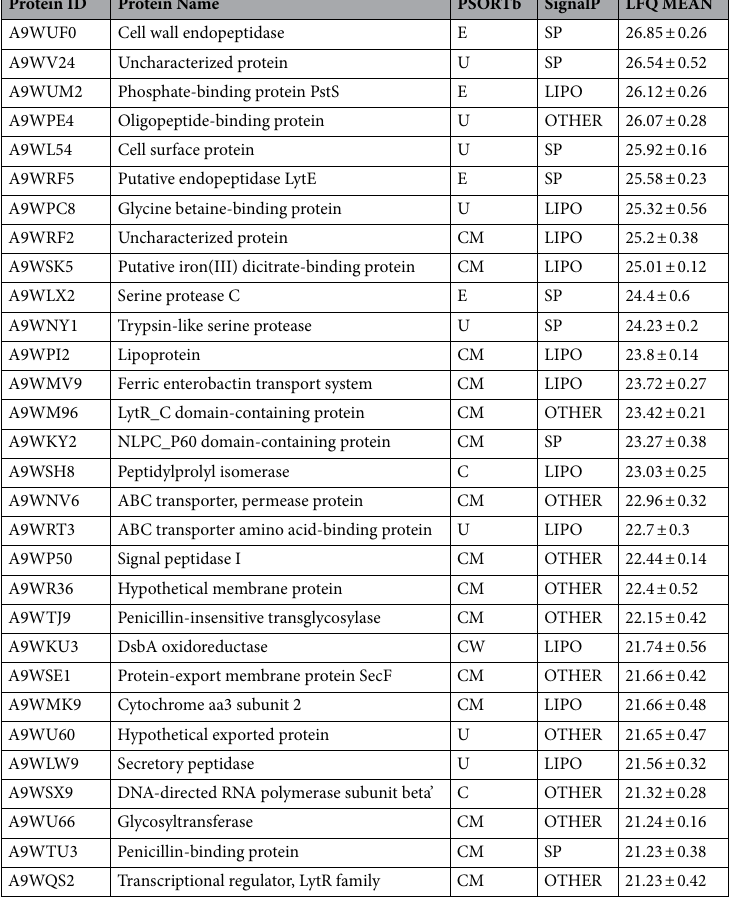
Table 2. The 30 most abundant proteins quantified in the membrane vesicle (MV) fraction of R. salmoninarum. Proteins are listed with their UniProt-ID and annotated protein name, their predicted PSORTb localizations (U = unknown; C = cytoplasmic; CM = cytoplasmic membrane; CW = cell wall; E = extracellular), their signal peptides predicted by SignalP (SP = secretory signal peptides transported by the Sec translocon and cleaved by Signal Peptidase I; LIPO = lipoprotein signal peptides transported by the Sec translocon and cleaved by Signal Peptidase II; OTHER = no detectable signal peptide) and sorted by their mean log2 transformed LFQ intensities in the MV fractions (n =